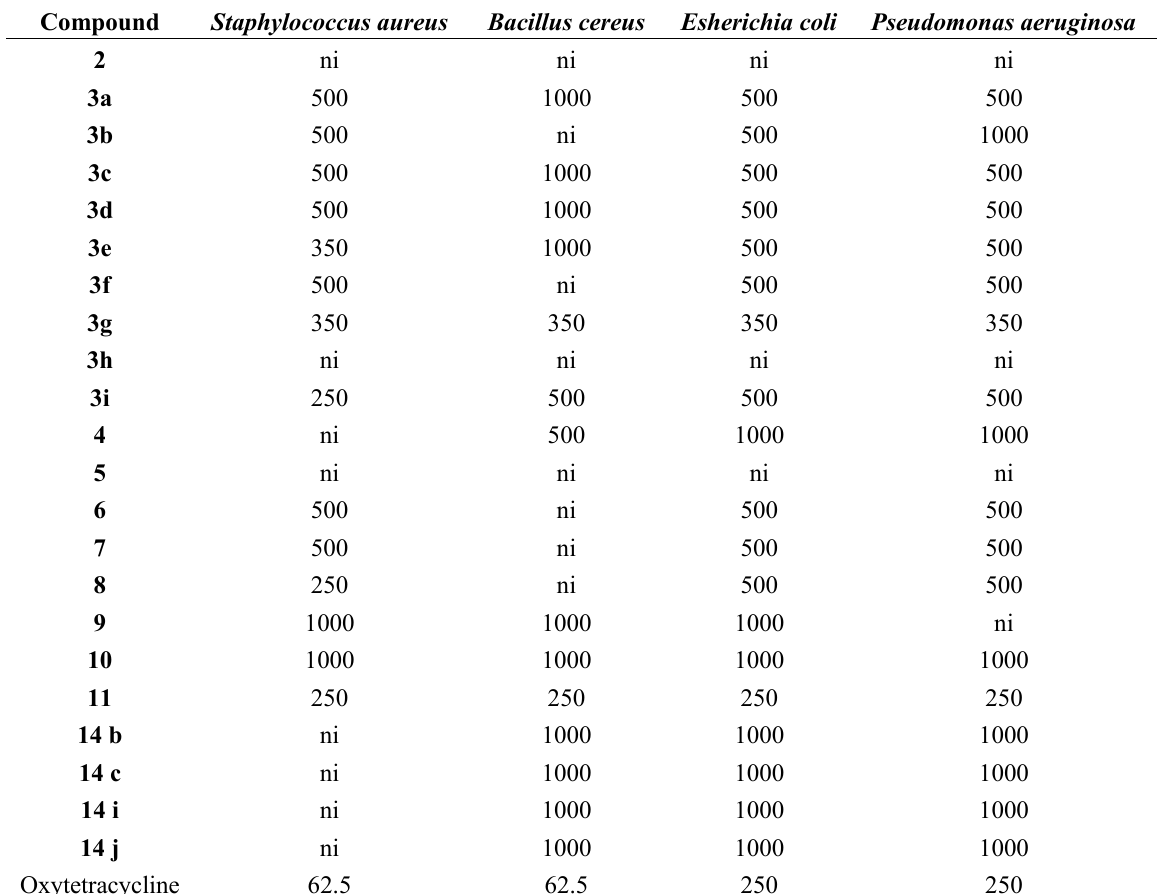
Table 2. Bactericidal activity in vitro of the synthesized compounds (MBC, µg/mL) Compound